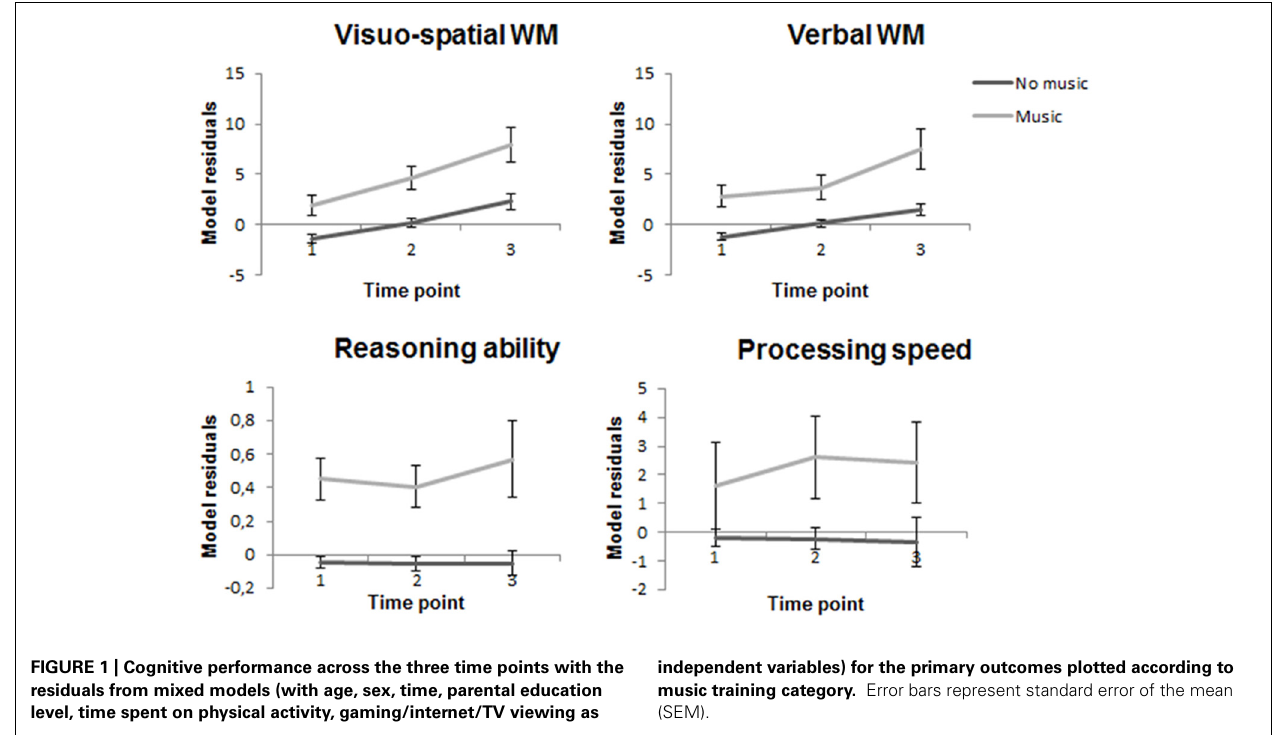
FIGURE 1 | Cognitive performance across the three time points with the residuals from mixed models (with age, sex, time, parental education level, time spent on physical activity, gaming/internet/TV viewing as